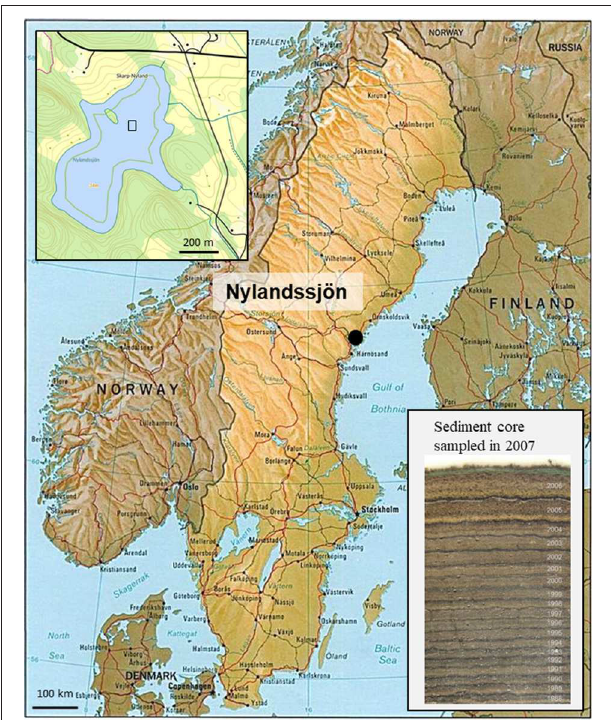
FIGURE 1 | Location of Nylandssjön (Sweden), with an inset map of the lake on the top-left. The 50 × 50m area where sediment cores were retrieved is marked with a square box. Inset photograph on bottom-right shows a sediment frozen core sampled in 2007; the dark winter layer separates each varve year (end of winter to following end of